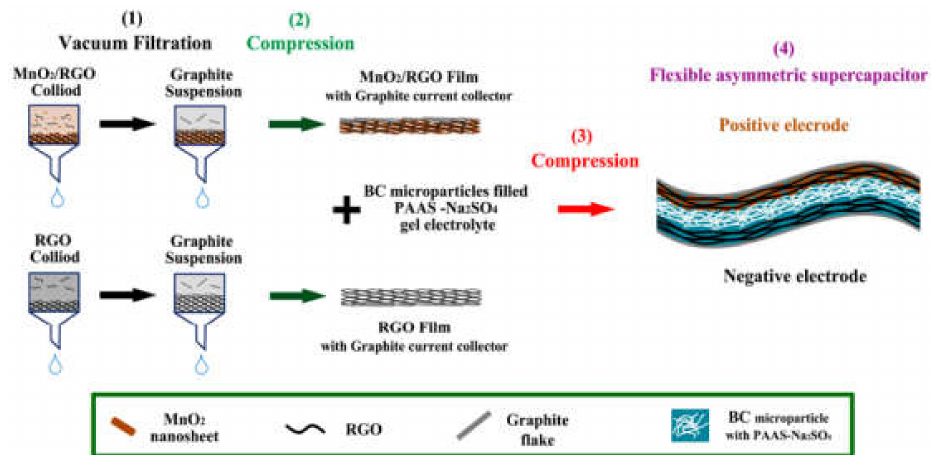
Figure 8. Synthesis of RGO and MnO 2 /RGO for supercapacitors through the vacuum filtration method. Reproduced with permission from [144]. Materials,